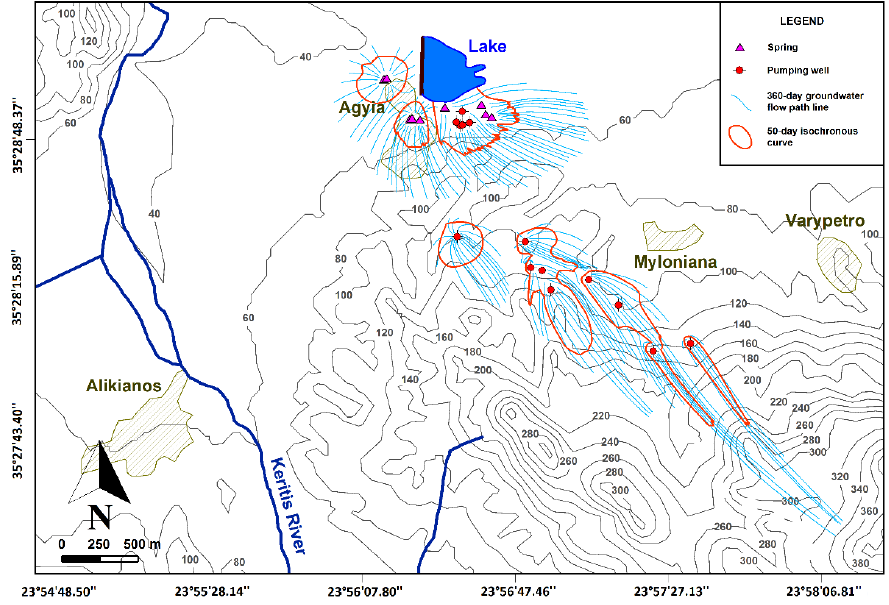
Figure 11. Groundwater flow path lines to the springs and pumping wells. The isochronal curves of 50-days are also shown.